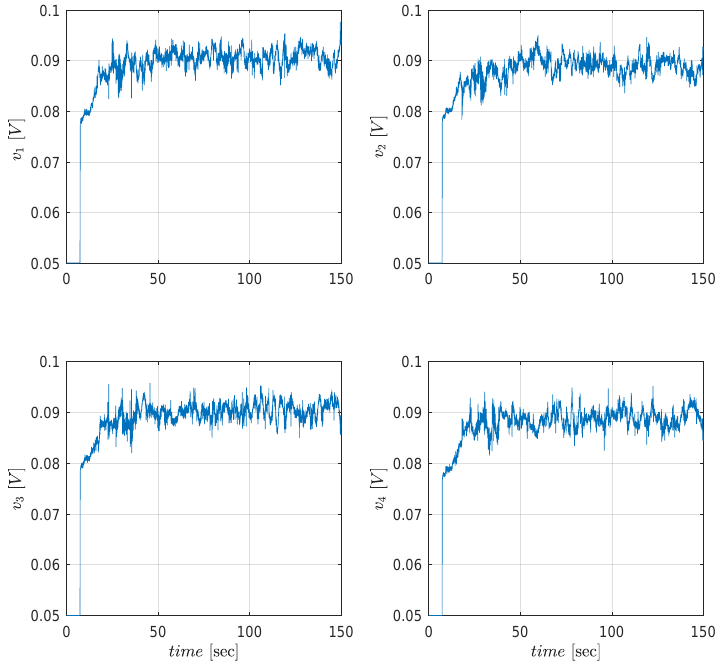
Figure 14. Motor PWM control inputs v r